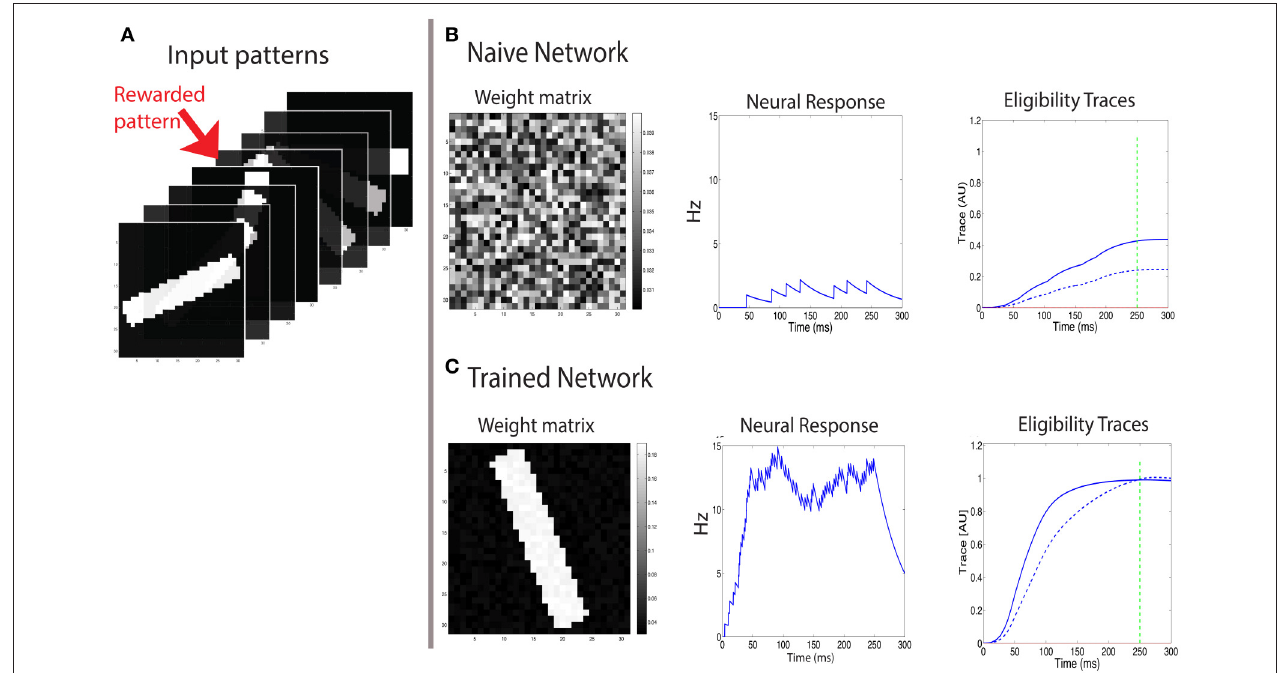
FIGURE 5 | Learning to respond to a rewarded pattern. (A) A set of input patterns that are presented to the input layer, only one (red arrow) is rewarded. Other patterns are not rewarded. In this example, the number of patterns is P = 8, and the pattern dimension is 31 × 31. Here a discrete reward is delivered 250ms after stimulus onset. (B) Before training, the weight vector is chosen to be random (left) and the response to all patterns is similar and weak (center). The two eligibility traces are increased due to the stimulus, and at the time of reward (green dashed line) the LTP trace (blue solid line) is stronger than the LTD trace (blue dashed line), resulting in potentiation of stimulated synapses. (C) After training, the weight vector has the same structure as the rewarded pattern (left), the response to the rewarded pattern (center) is strong, and the response to other patterns is much weaker. At the time of reward (vertical green dashed line), the LTP and LTD traces are equal in magnitude, such that no further changes in synaptic efficacies occur on